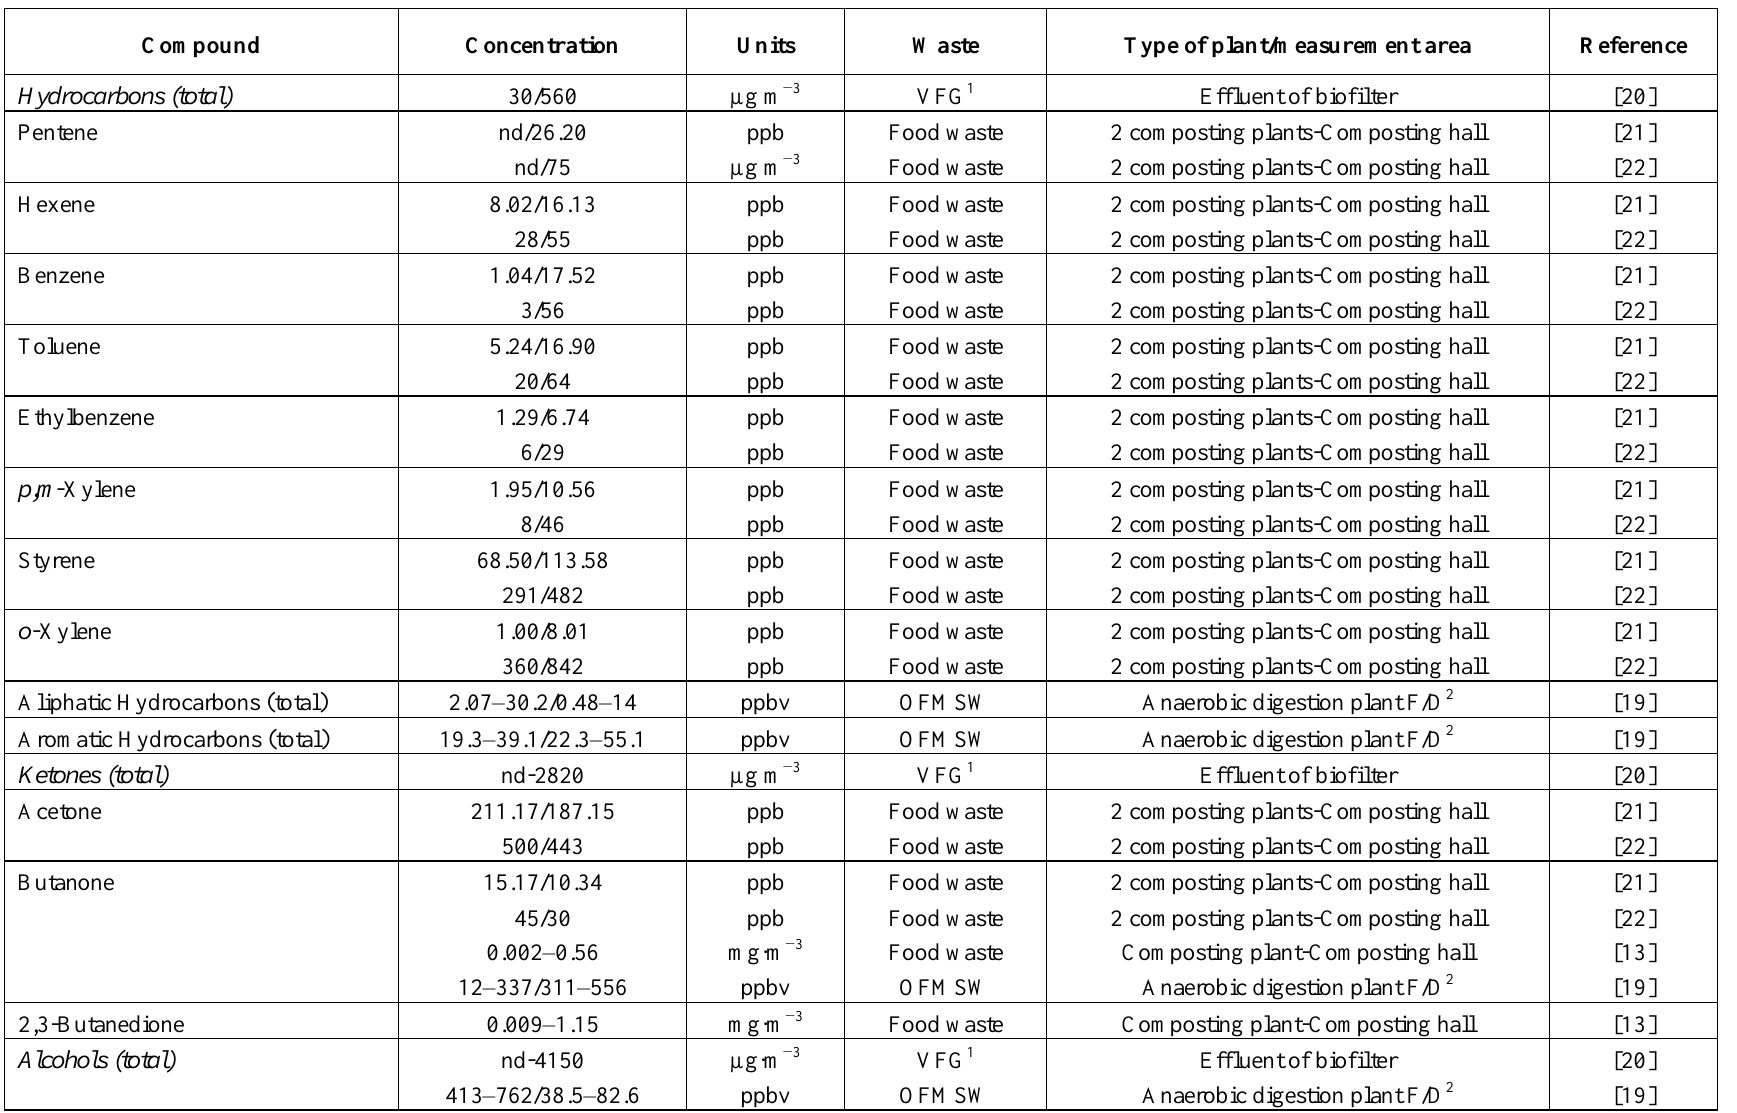
Table 1. VOC emissions from waste treatment